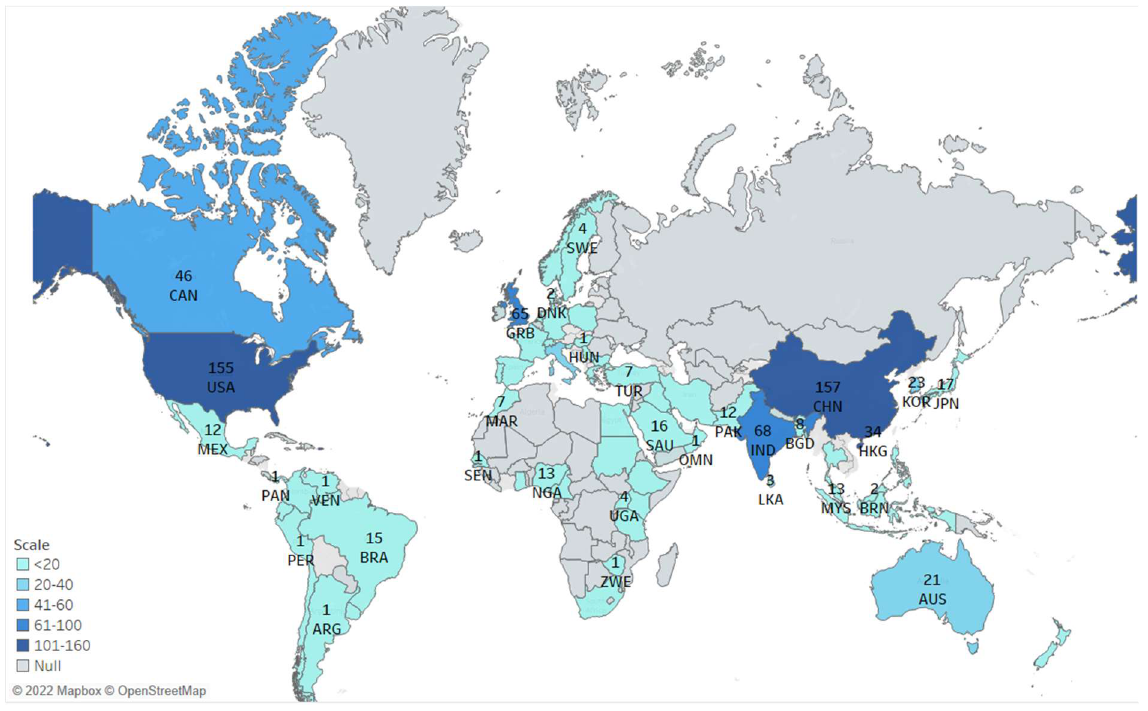
Figure 2. Country–Specific Production (Based on Corresponding Author).